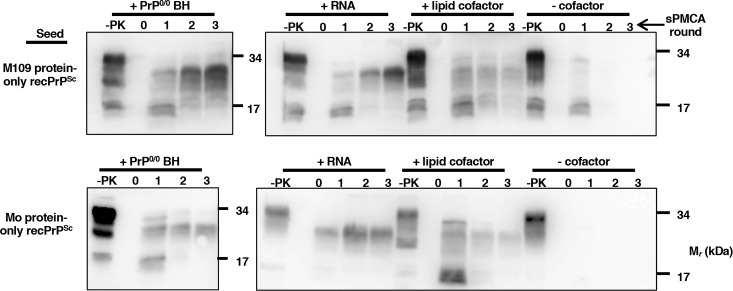
Protein-only recPrPSc seeds require cofactor molecules to convert immunopurified BV PrPC to PrPSc.Western blots probed with anti-PrP mAb 27/33. Immunopurified M109 BV PrPC substrate was supplemented with, from left to right, PrP0/0 BH, RNA, purified lipid cofactor, or PBS and 1% Triton X-100 buffer (-cofactor), as indicated. All of the reconstituted reactions were then seeded with BV M109 protein-only recPrPSc (top), or Mo protein-only recPrPSc (bottom), and subjected to three-round sPMCA.